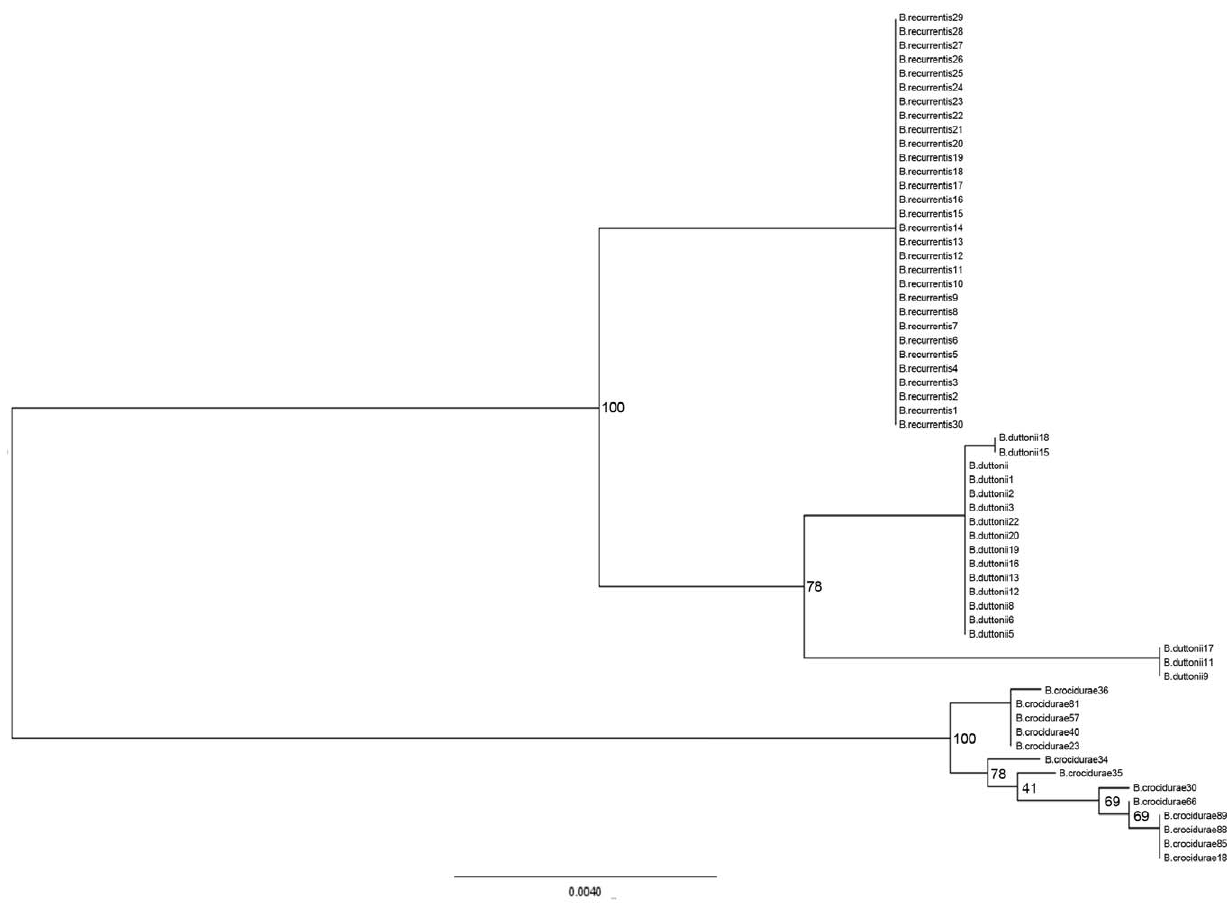
Figure 2. Maximum-likelihood tree based on five intergenic spacers sequences for 61 Borrelia strains. To examine the confidence of ML tree, 100 bootstrap replicates were used.